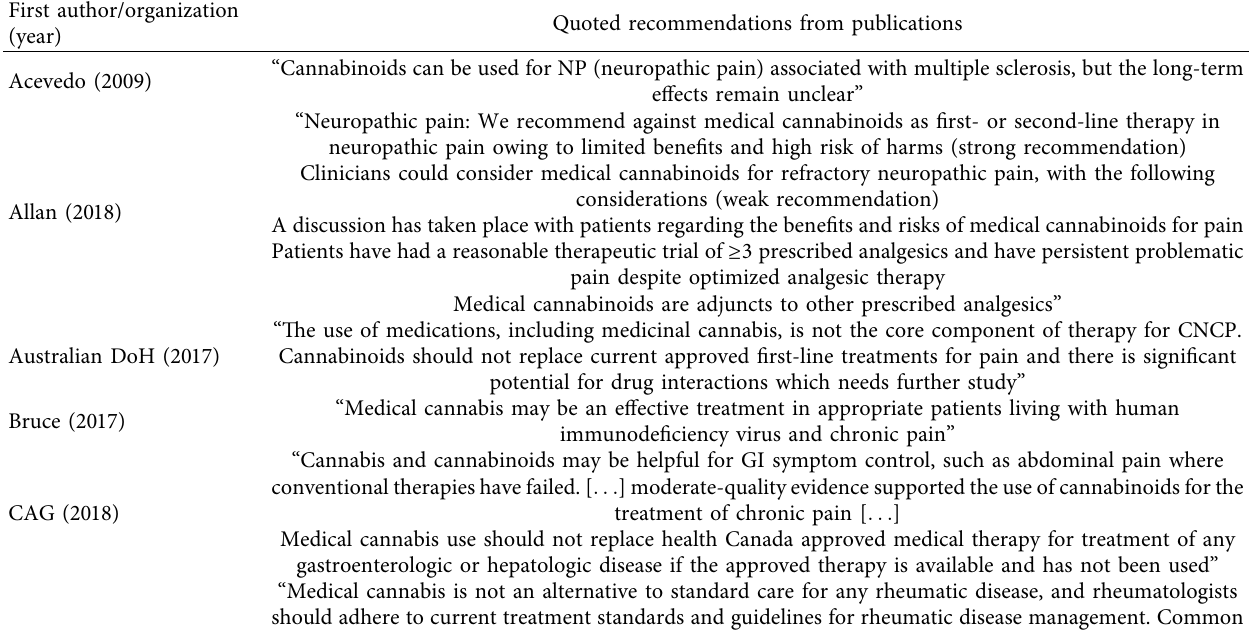
Table 2: Quotes of recommendations from included